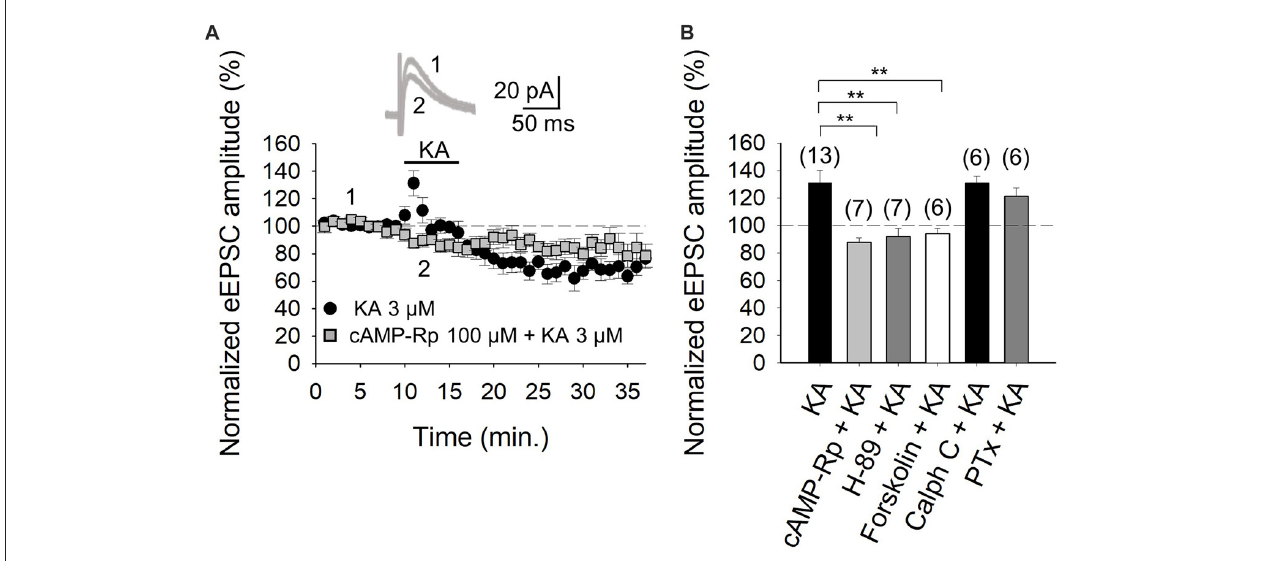
FIGURE 2 | Activation of adenylyl cyclase (AC) and downstream protein kinase A (PKA) underlies the kainate-mediated facilitation of glutamate release in PF-PuC synapses. (A) Time-course of the effect of KA on eEPSC amplitude in cAMP-Rp treated slices. Inset shows representative traces showing that KA (3 µ M) does not increase the amplitude of the eEPSCs in cAMP-Rp treated slices. (B) Inhibition of PKA by cAMP-Rp (100 µ M) or H-89 (2 µ M) and activation of AC by forskolin (30 µ M) prevented the facilitatory action of KA. Inhibition of protein kinase c (PKC) with calphostin C (1 µ M) has no effect on the KA enhancement of the eEPSC amplitude. The facilitatory effect of KA is not affected in slices treated with pertussis toxin. The number of slices (from two to three mice) is indicated in parenthesis at the top of each bar. Results are expressed as means ± SEM ( ∗∗ P < 0.01, ANOVA